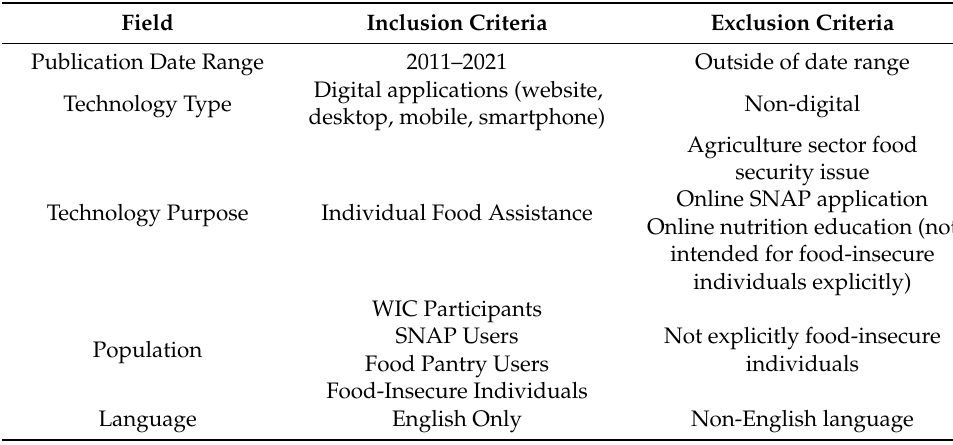
Table 2. Article inclusion and exclusion